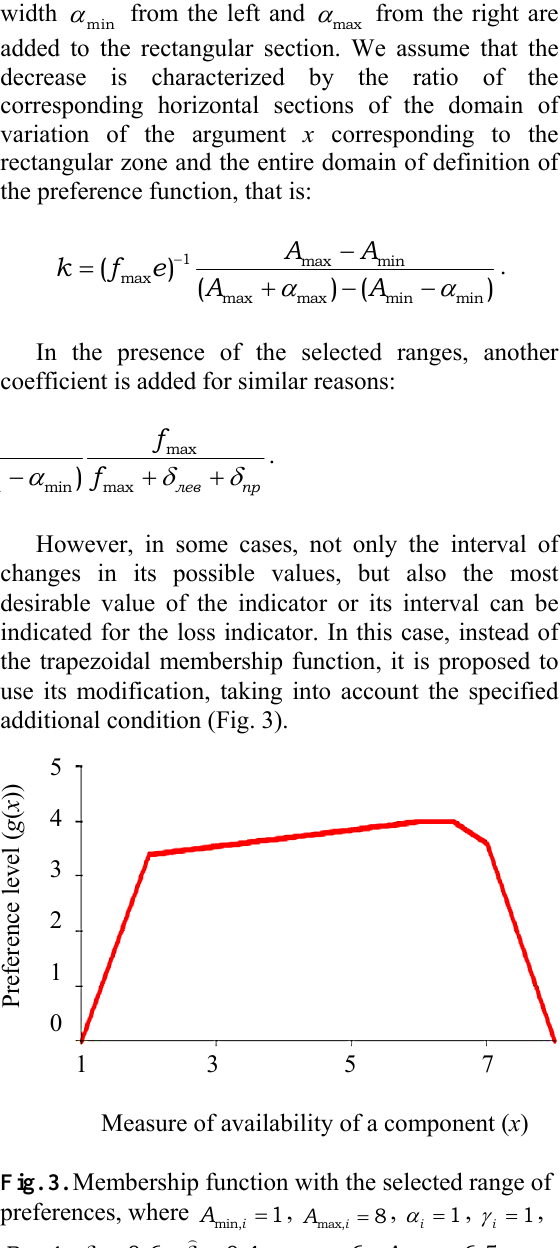
Fig. 3. Membership function with the selected range of preferences, where